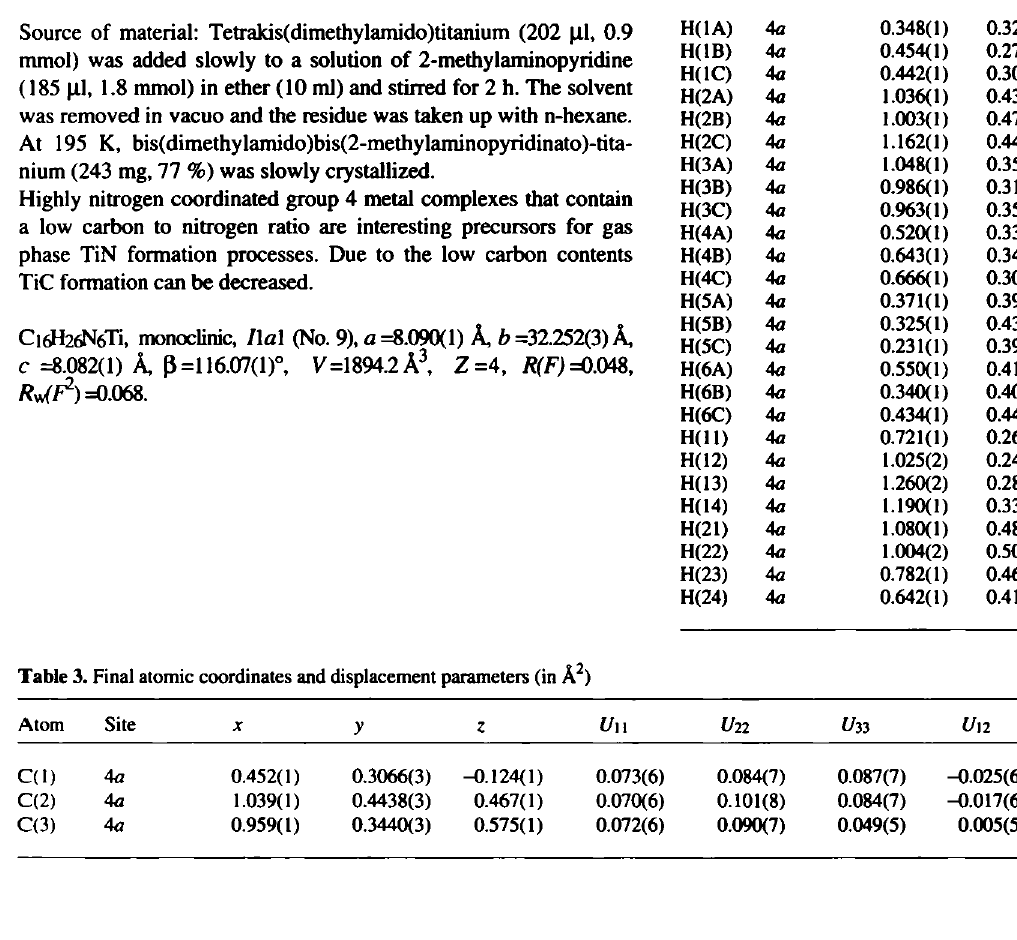
Table 2. Final atomic coordinates and displacement parameters (in Â 2 )